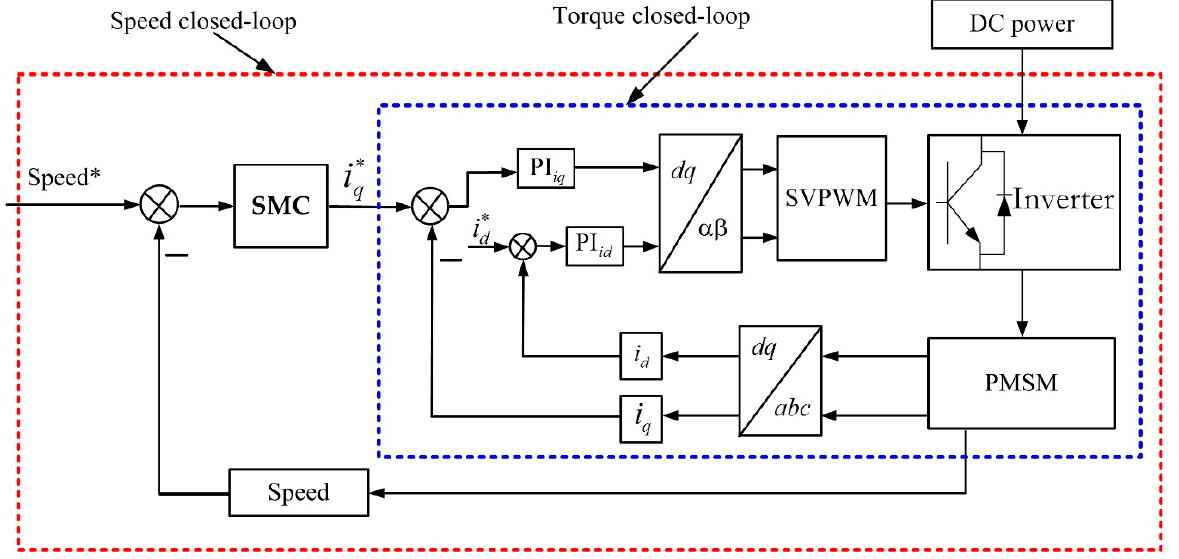
Figure 1. The structure of control model of a